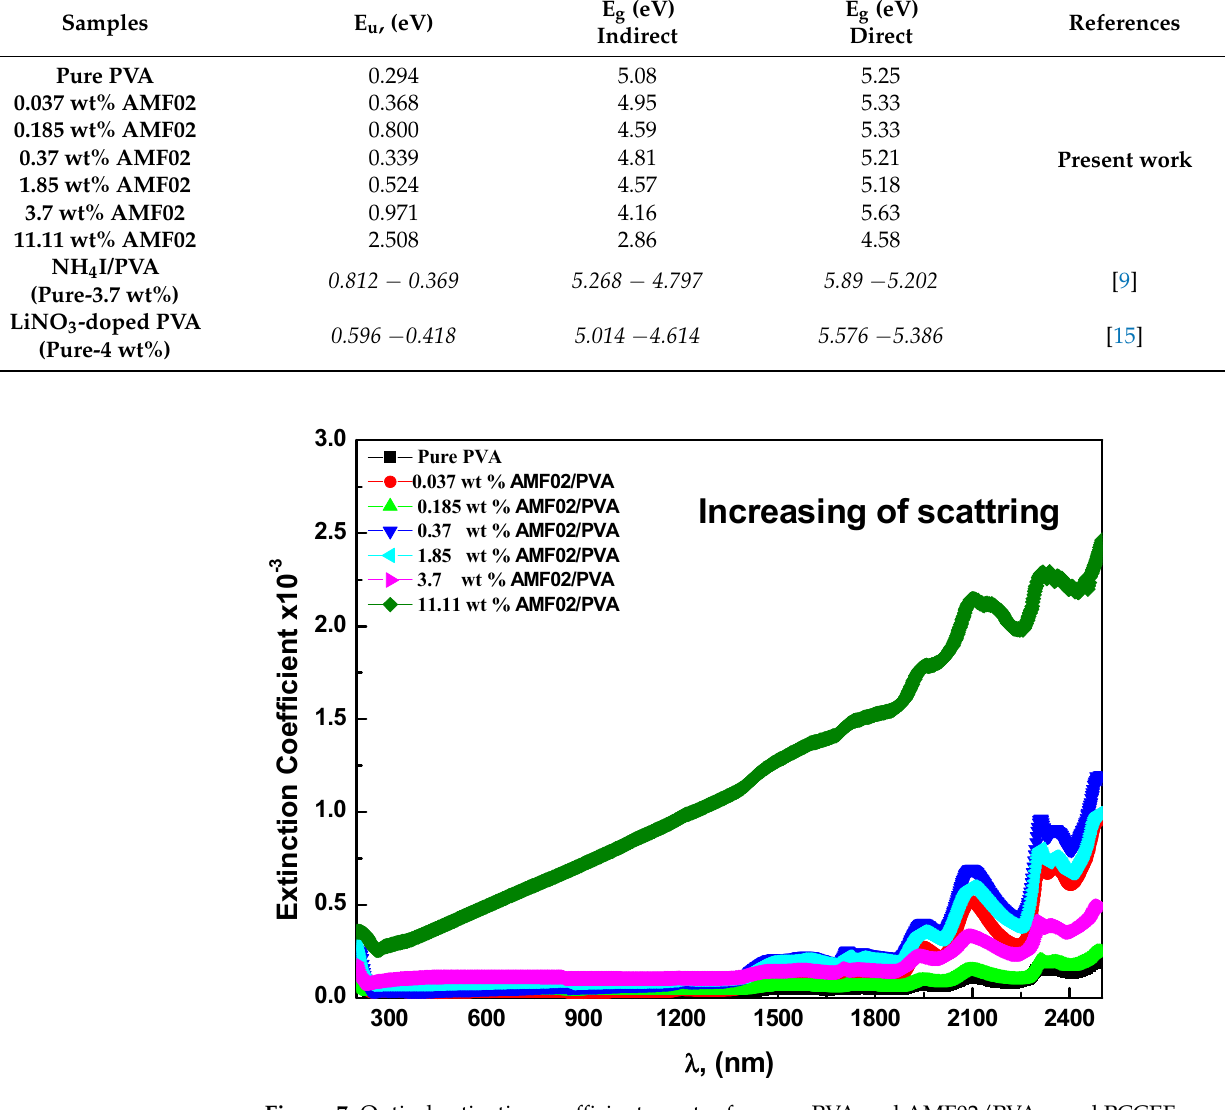
Figure 7. Optical extinction coefficient spectra for pure PVA and AMF02/PVA novel PCCEFs.